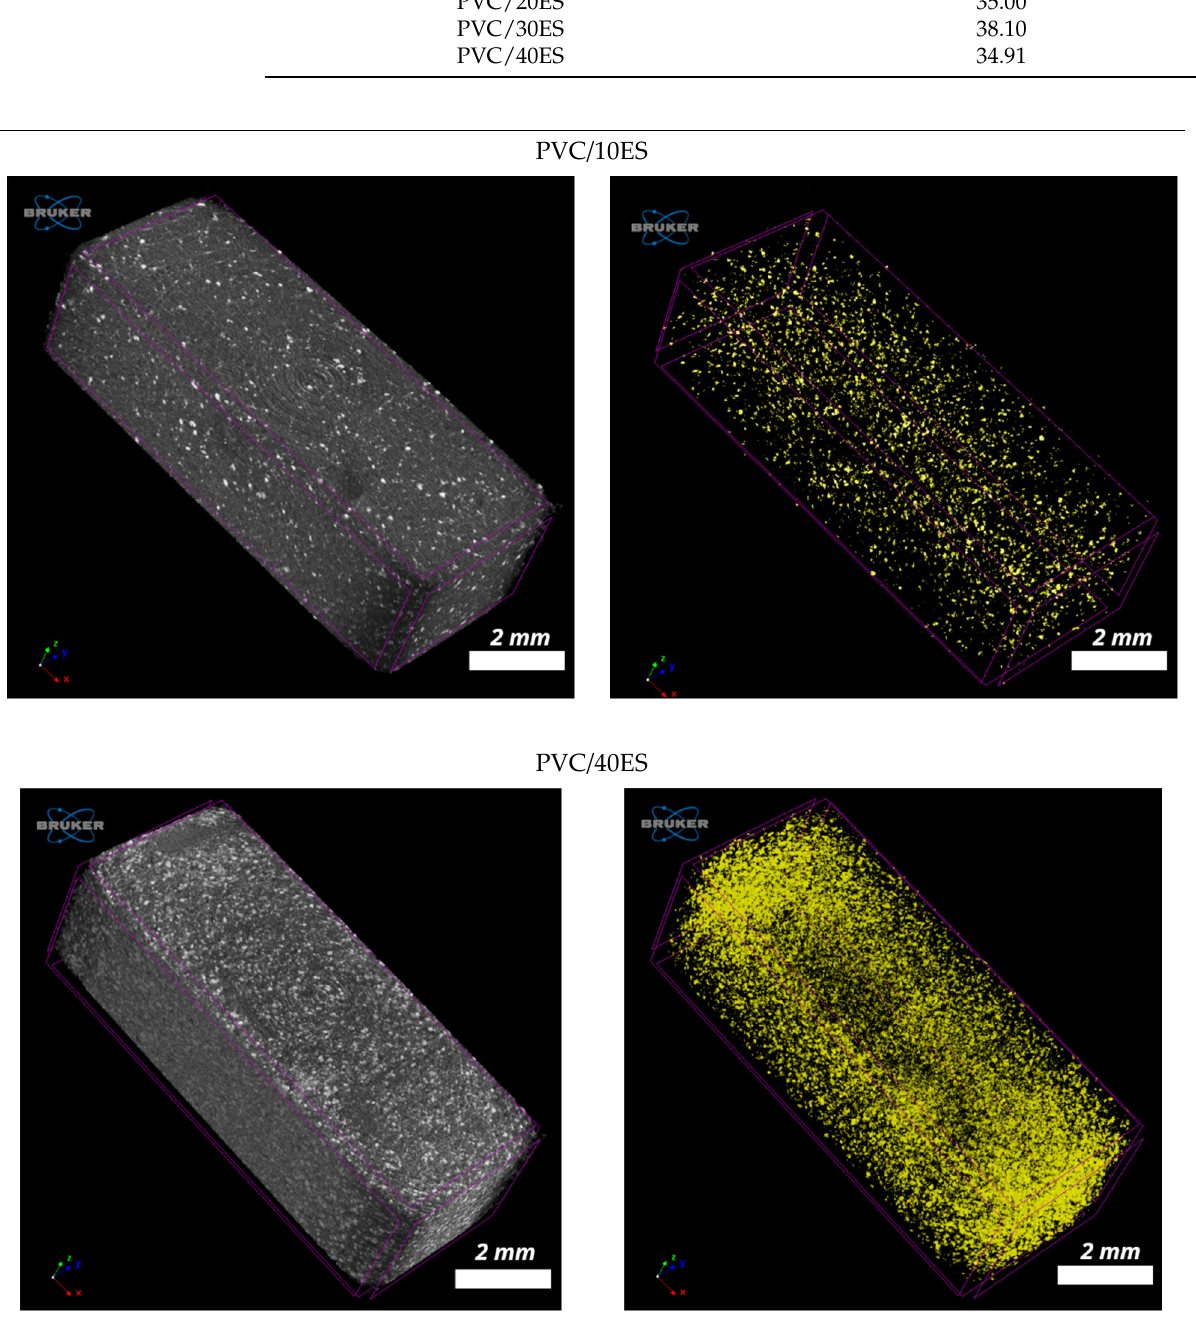
Figure 12. The 3D visualizations of pieces scanned with microcomputed tomography (the left column ) and the same pieces after removing the PVC matrix, with ES particles as yellow spots.